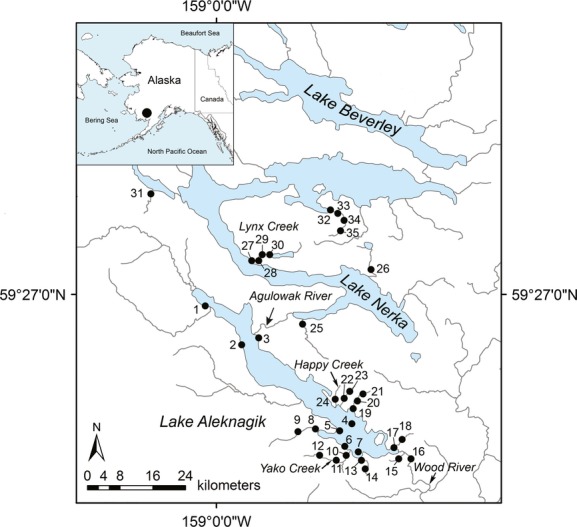
Map showing sampling localities in Lake Aleknagik and Lake Nerka, the first two interconnected lakes in the Wood River Lakes system, southwestern Alaska, USA. 1–7 = Aleknagik lake sites; 8–9 = Bear Creek; 10–12 = Yako Creek; 13–14 = Whitefish Creek; 15 = Silver Salmon Creek; 16 = Wood River; 17–18 = Mission Creek; 19–21 = Eagle Creek; 22–23 = Hansen Creek; 24 = Happy Creek; 25 = Fenno Creek; 26 = Teal Creek; 27–30 = Lynx Creek; 31 = Little Togiak River; 32–35 = Hidden Lake Creek.